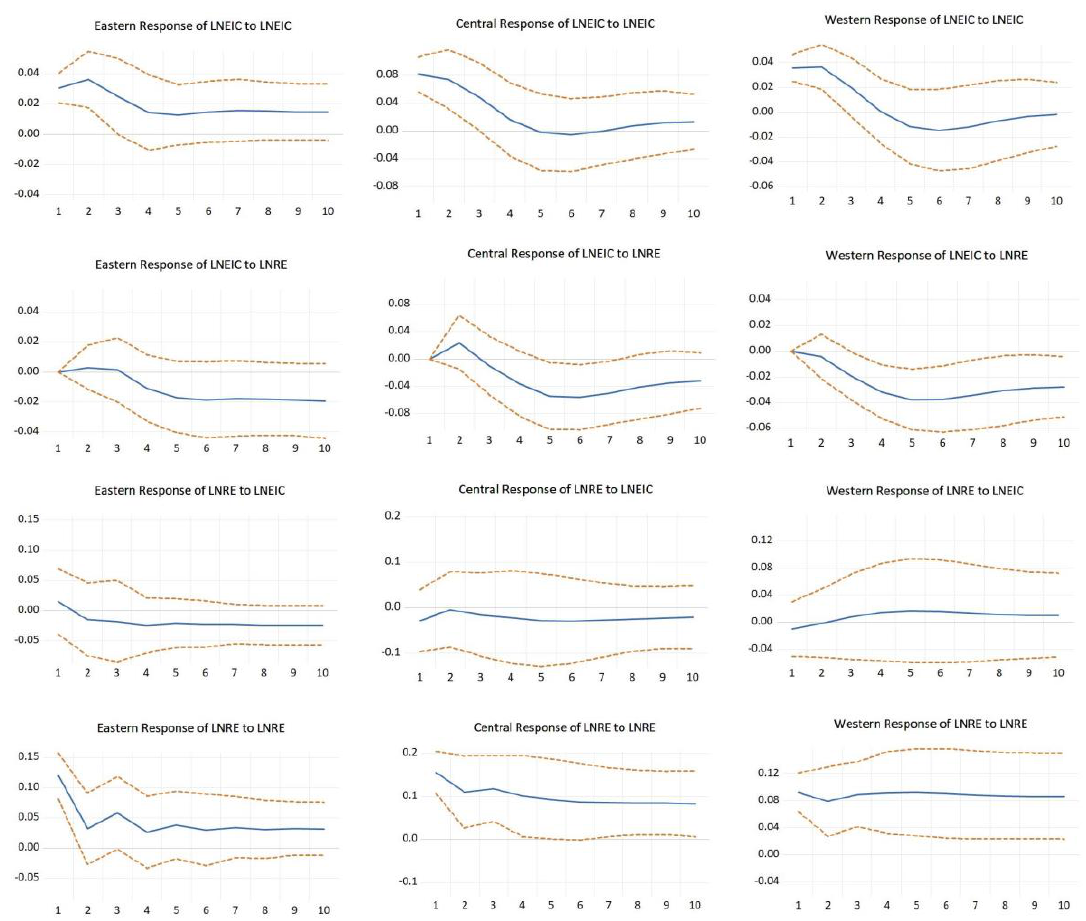
Figure 4. Impulse response results for the three economic regions.